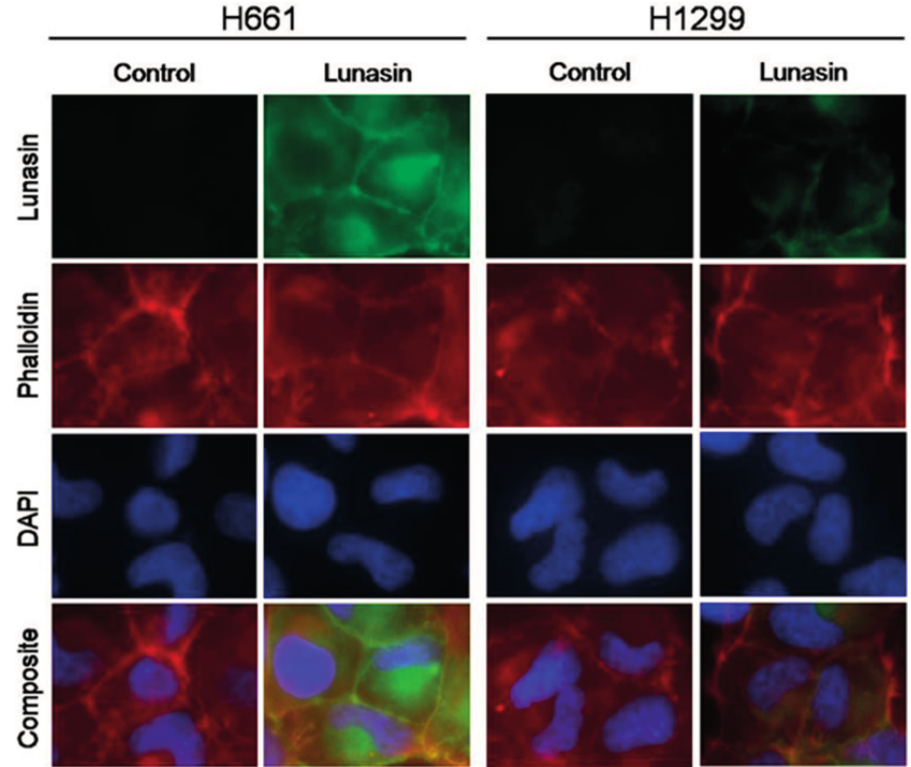
Figure 1. Internalization of lunasin into non-small cell lung cancer (NSCLC) cells. Cells were treated for 24 h with either vehicle (Control) or 100 µM lunasin prior to processing for